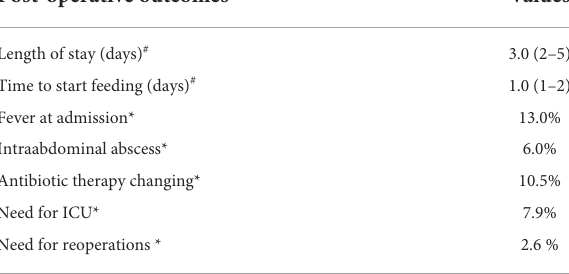
TABLE 3 Post-operative outcomes ( n = 469).